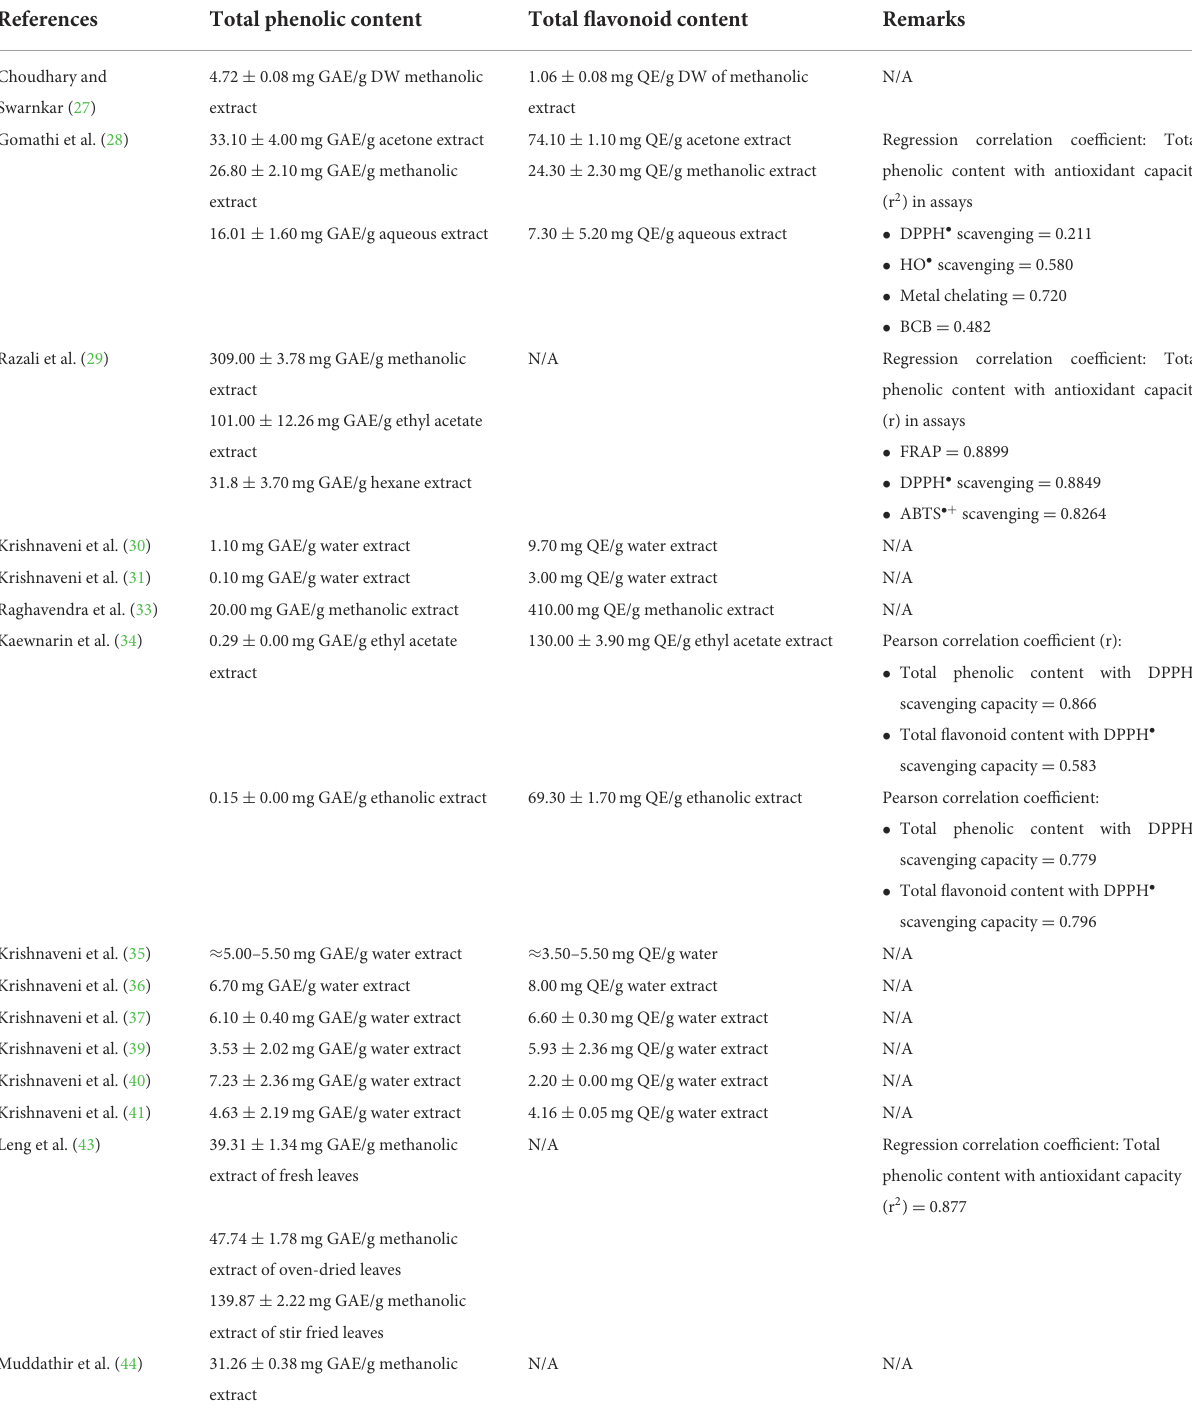
TABLE 3 Total polyphenol and total flavonoid contents of T. indica leaf